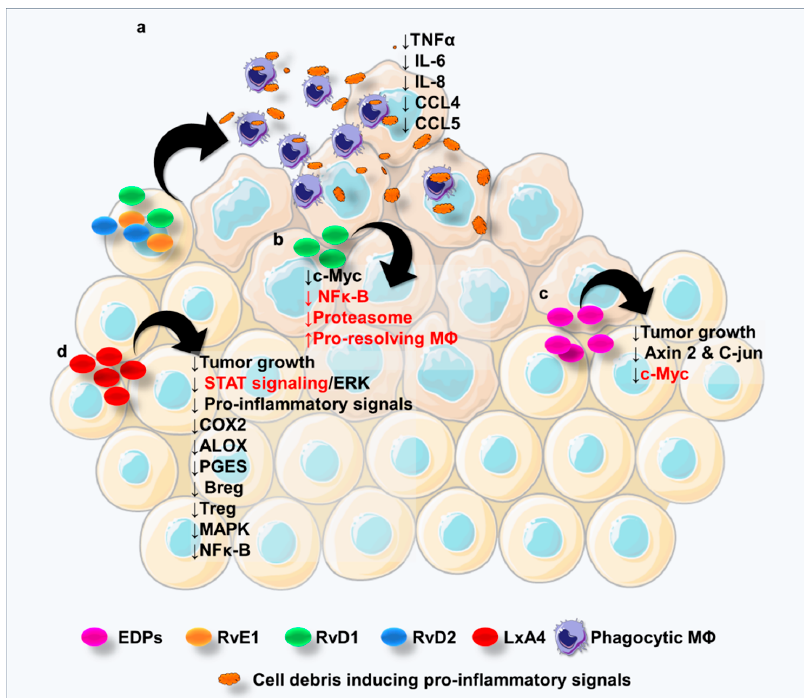
Figure 3. Pro-resolving lipid mediators in CRC. Cartoon showing the CRC-associated pro-resolving lipids. ( a ) RvE1, RvD1, and RvD2 block the cell debris-induced TNF α , IL-6, IL-8, CCL4, and CCL5 release. ( b ) RvD1 inhibits c-Myc expression by tumoral cells through the inhibition of NF κ -B signaling, proteasome, and pro-resolving M Φ . ( c ) CYP450-metabolized epoxydocosapentaenoic acids (EDPs) inhibit tumor growth and the expression of pro-oncogenic c-Myc, Axin2, and C-jun genes. ( d ) LXA4 inhibits tumor cell growth, and its beneficial role is mediated by Breg cell inhibition through inactivation of Extracellular Signal-Regulated Kinases (ERK) and Signal Transducers and Activators of Transcription (STAT) signaling, finally decreasing Treg cell in tumor-bearing mice; LXA4 upregulation is associated with the decreased synthesis of pro-inflammatory mediators and suppressed expression of COX-2, ALOX5, and mPGES. LXA4 reduces tumor growth by inhibiting the Mitogen-Activated Protein Kinase MAPK and NF- κ B pathways. The illustration was made with SMART Servier Medical Art free images (https: // smart.servier.com /